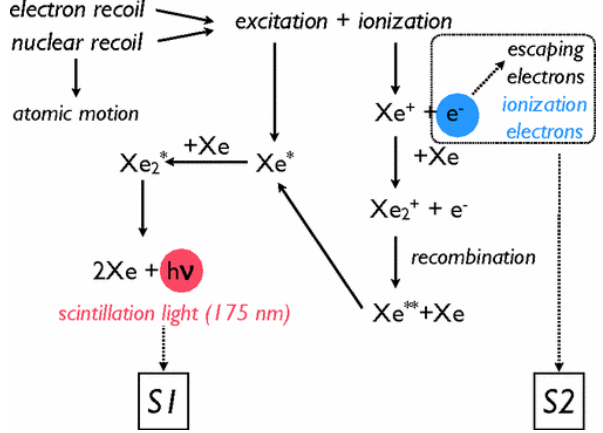
Figure 31: Schematic of scintillation production in two phase xenon detector. Ref. [ 43